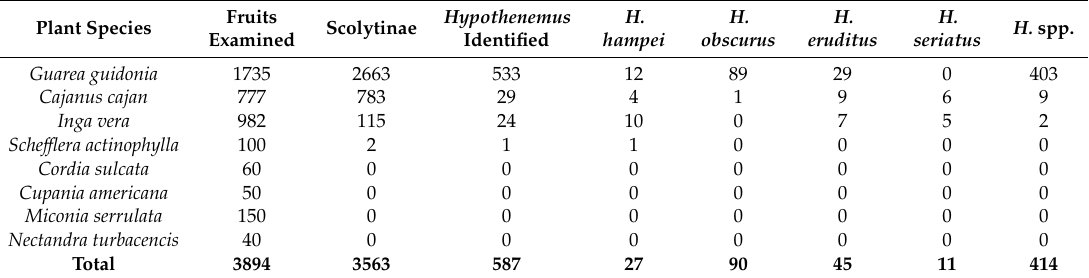
Table 3. Scolytinae and Hypothenemus spp. collected and identified in potential alternate host plants of the co ff ee berry borer in Puerto Rico. Numbers of beetles are